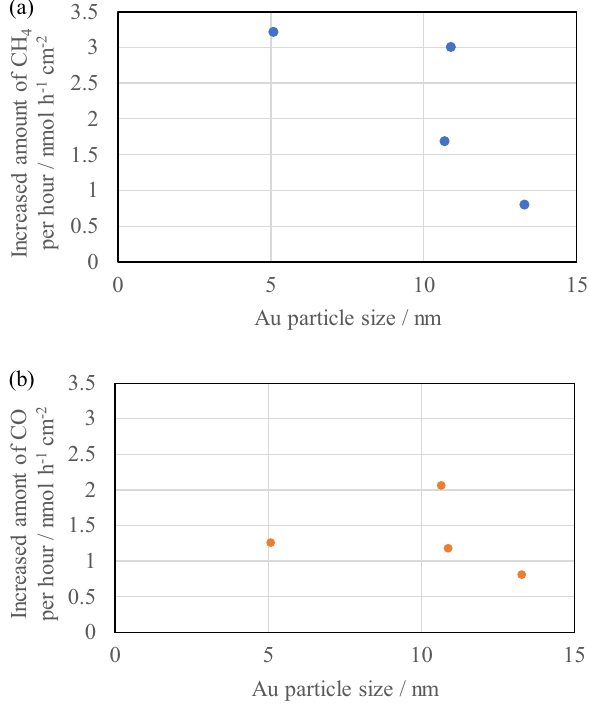
Fig. 14 Relationships between the Au particle size and the amounts of a CH and b CO produced per unit time, standardized 4 by unit